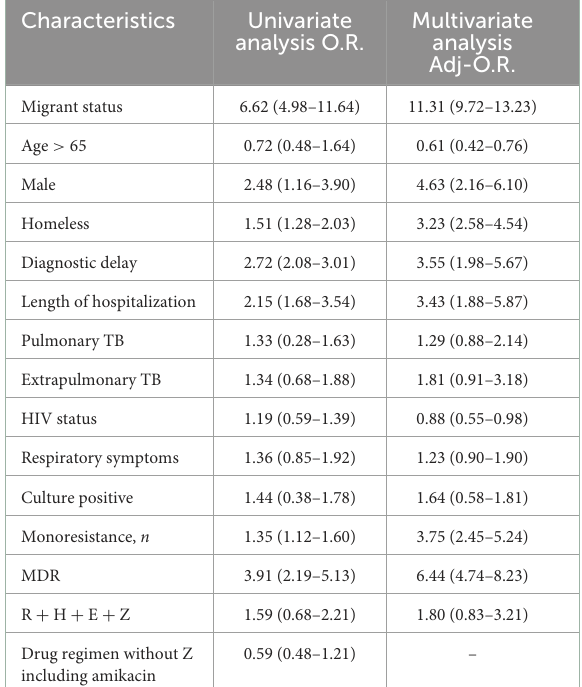
TABLE 3 Predictors of adverse events for active pulmonary tuberculosis.